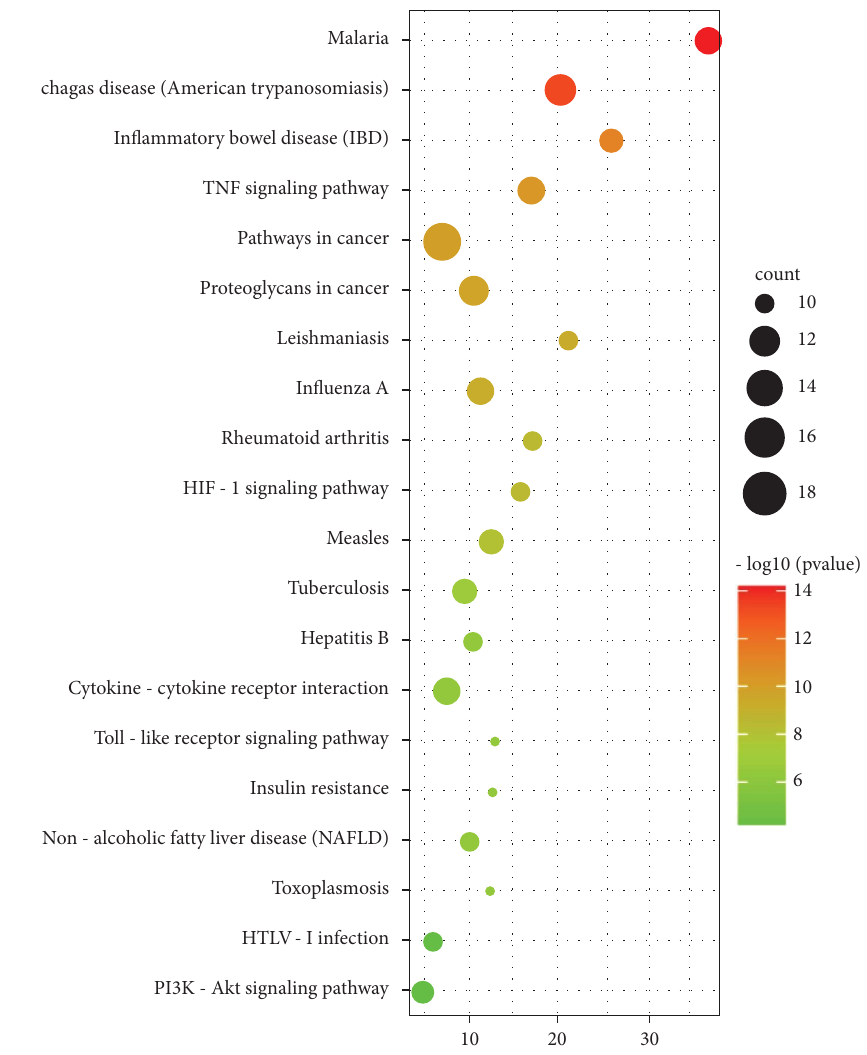
Figure 5: Signifcant pathway enrichment bubble diagram (top